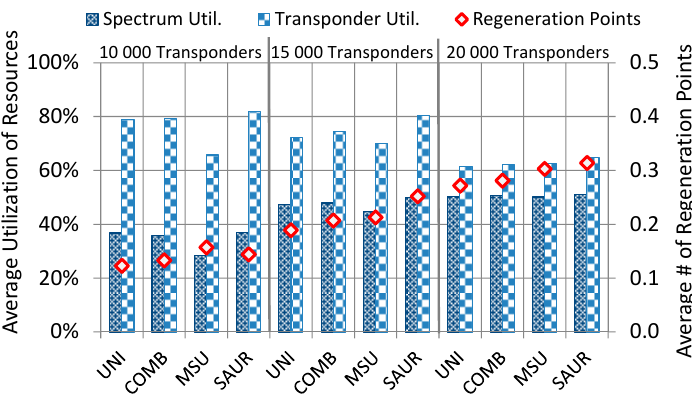
Figure 11. Utilization of spectrum and transponders and average number of regeneration points for the US26 network and TP A as a function of various algorithms and number of transponders.